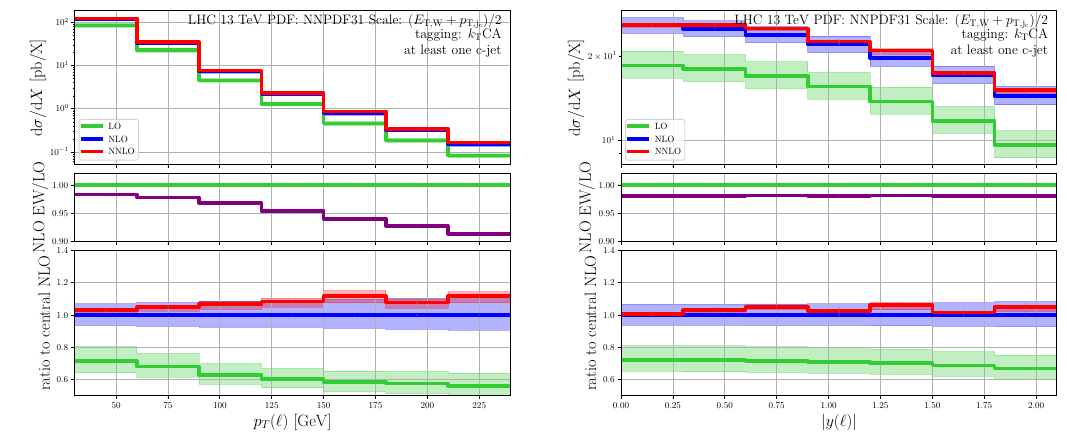
√ s = 13 TeV. No QCD corrections are included = 0 . 118 are used. s